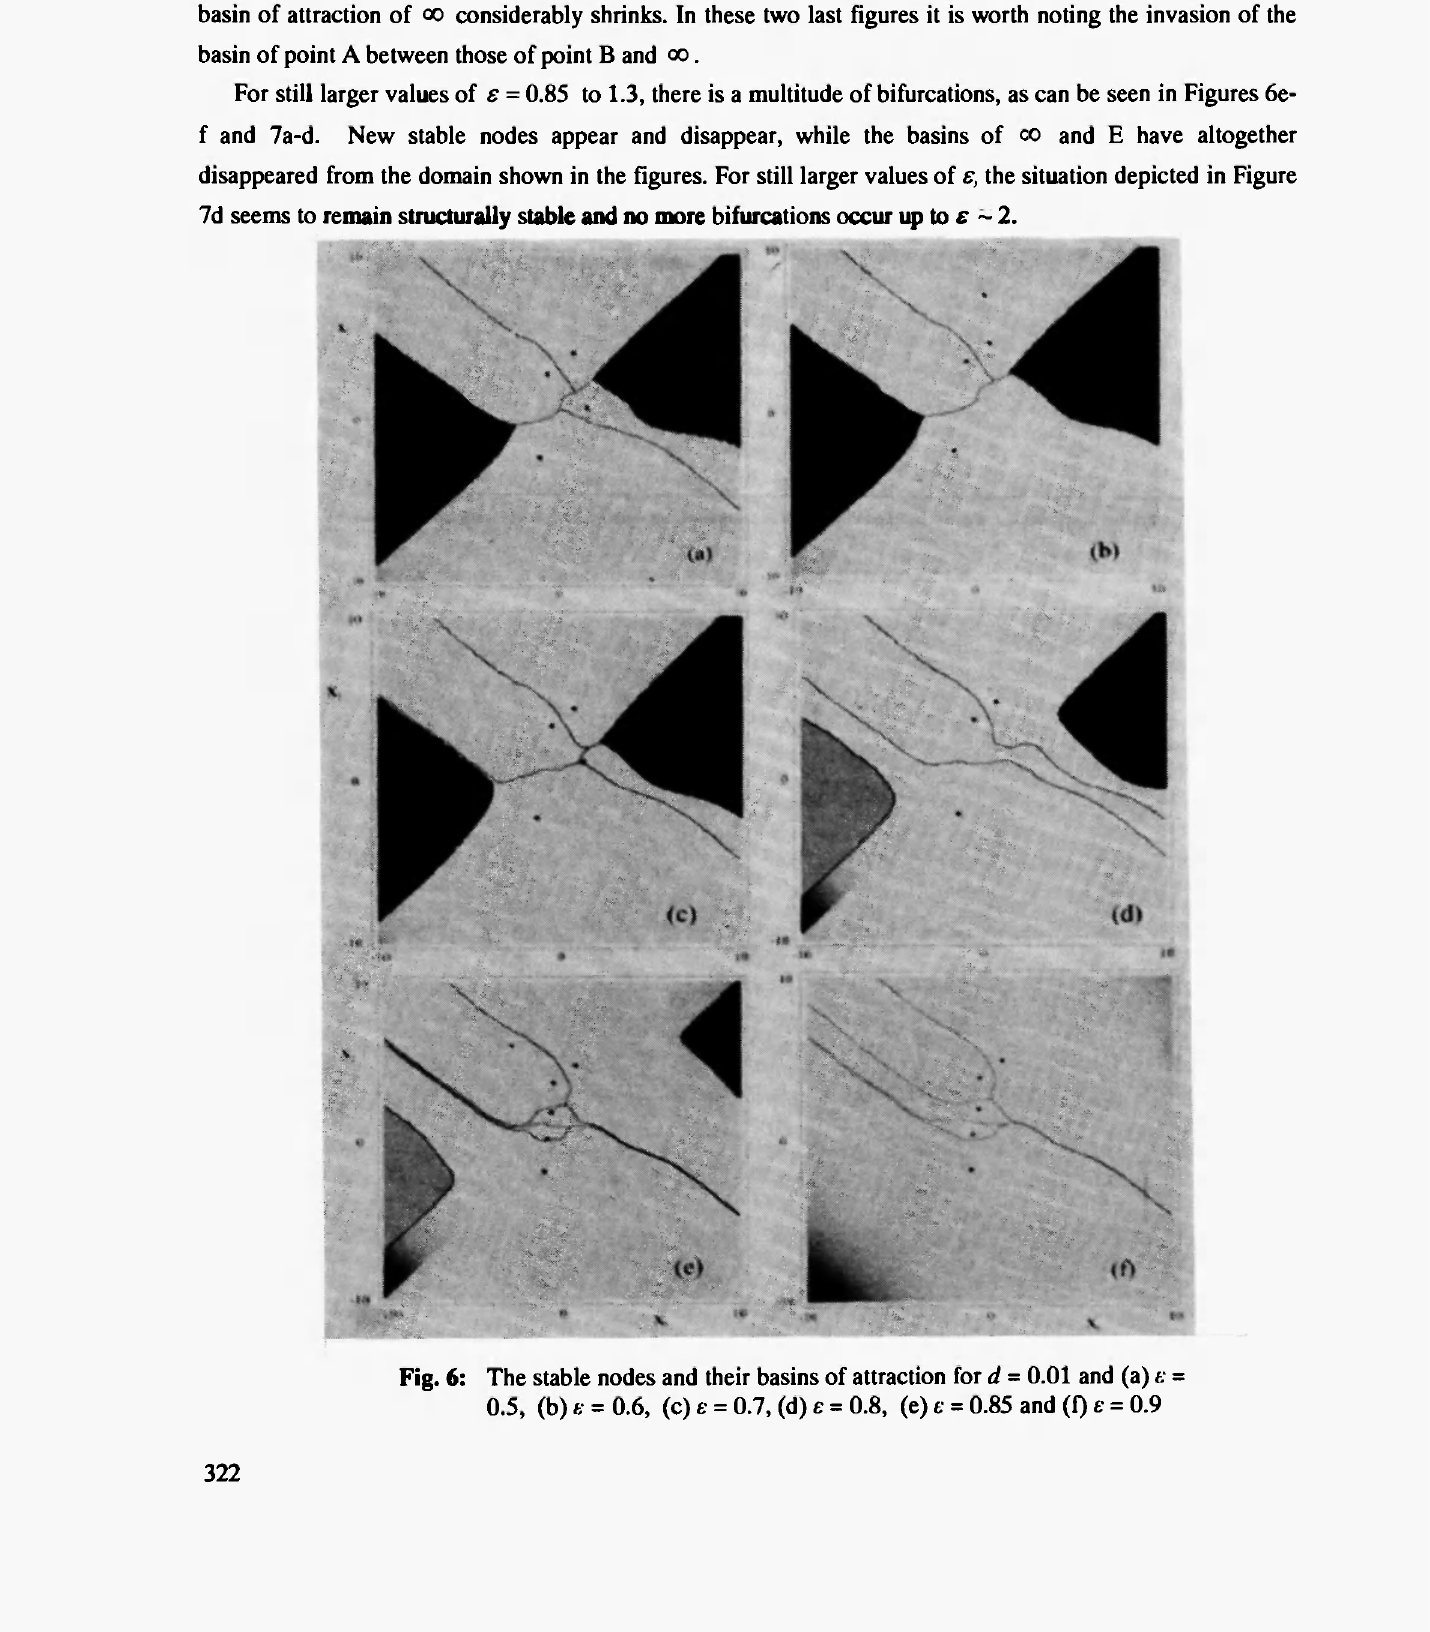
Fig. 6: The stable nodes and their basins of attraction for d = 0.01 and (a) ε